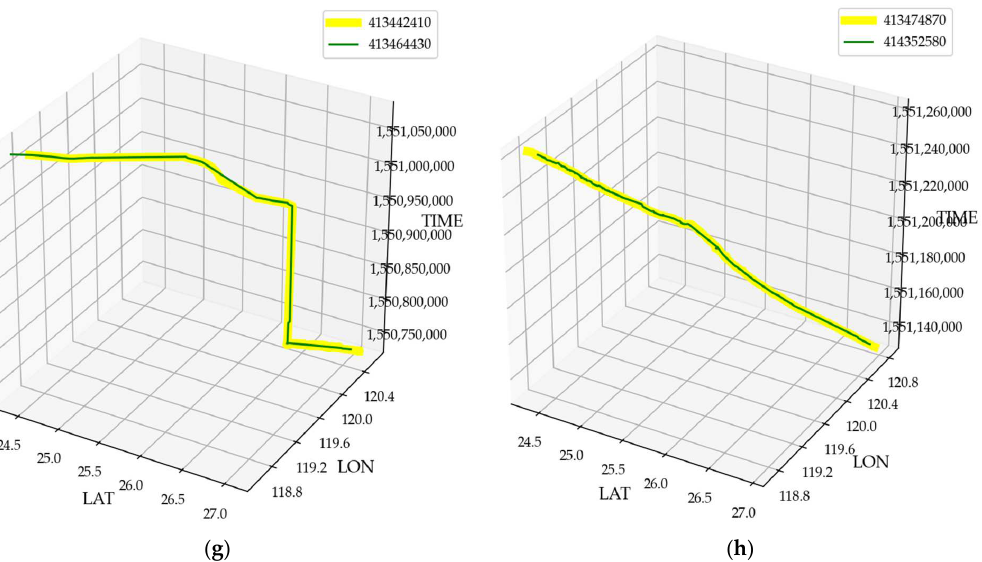
Figure 4. Spatiotemporal diagram of the STCP. ( a ) to ( h ) respectively represent the spatiotemporal trajectory of the 8 pairs of associated ships in Table 3.